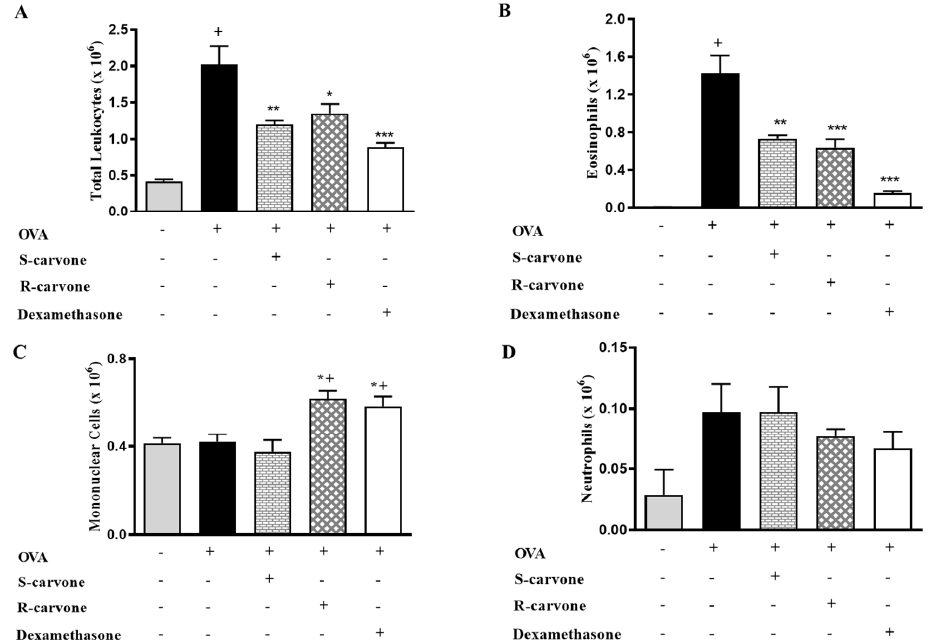
Figure 2. Effects of carvone enantiomers on leukocyte recruitment in allergic airway inflammation. ( A ) Total leukocytes, ( B ) Eosinophils, ( C ) Mononuclear cells and ( D ) Neutrophils per bronchoalveolar